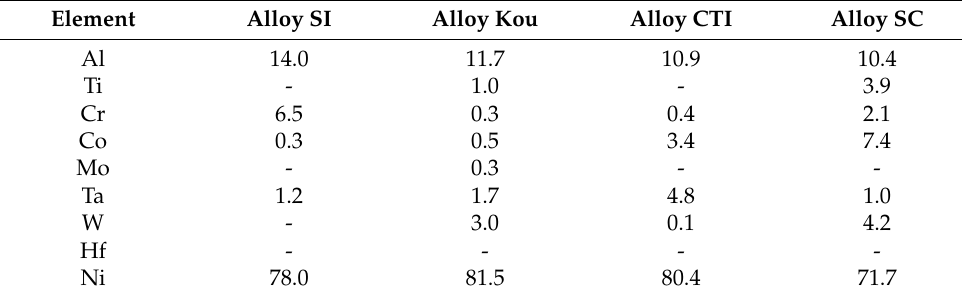
Table 4. Composition of designed alloys in at.%.